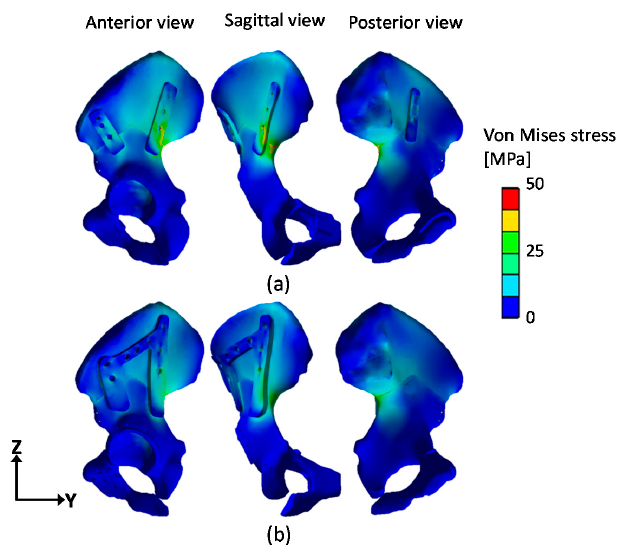
Figure 4. The von Mises stress distribution of the finite element (FE) models with ( a ) the straight-type plate fixation and ( b ) the horseshoe-shaped plate fixation.